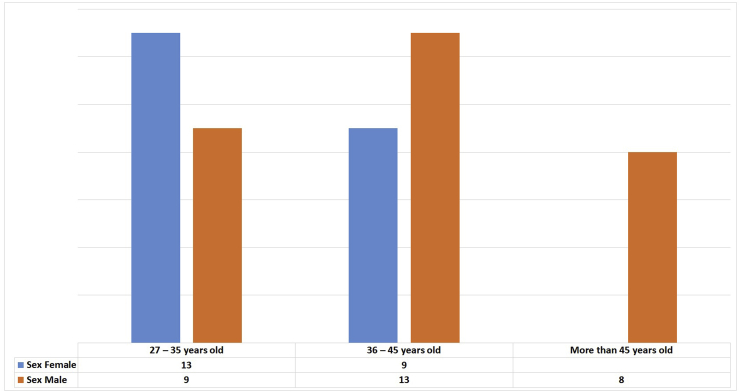
Distribution Caregivers -age and sex.